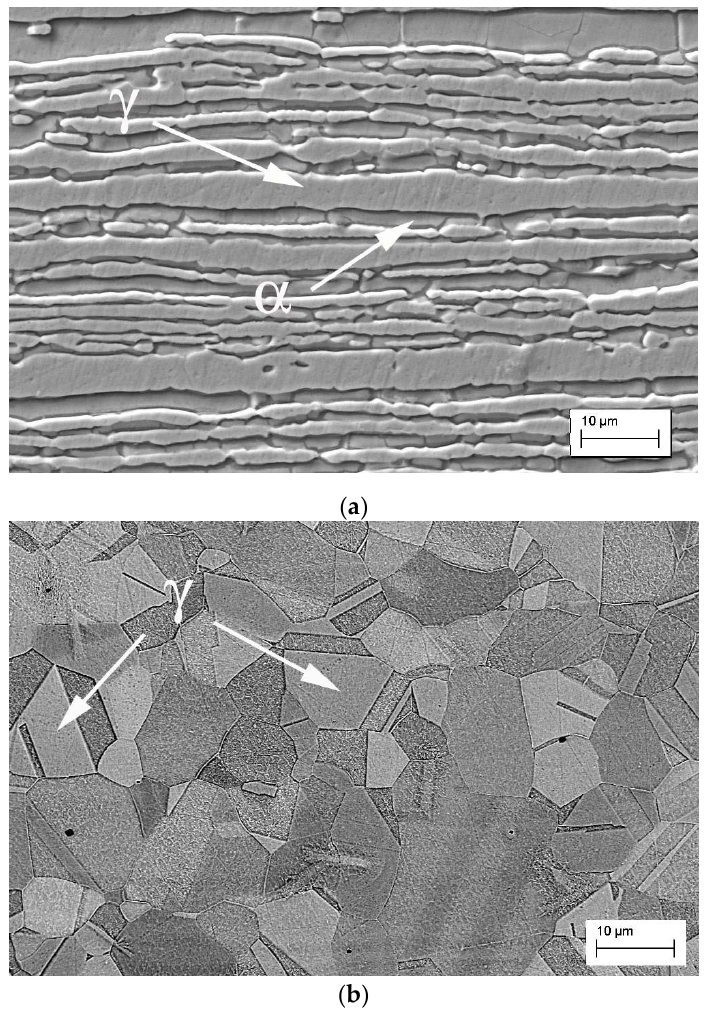
Figure 2. SEM micrographs of the base materials: ( a ) UNS S32750 duplex steel; ( b ) AISI 316L austenitic stainless steel. ( γ -austenite, α -ferrite).